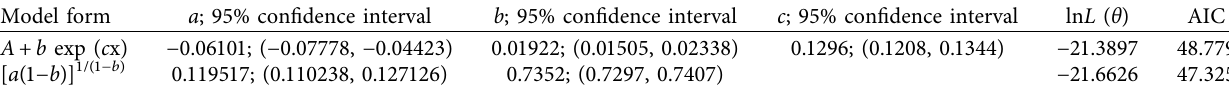
Figure 8: The segmented degradation process of the scroll wheel. Table 2: The estimated values and AIC of different models.